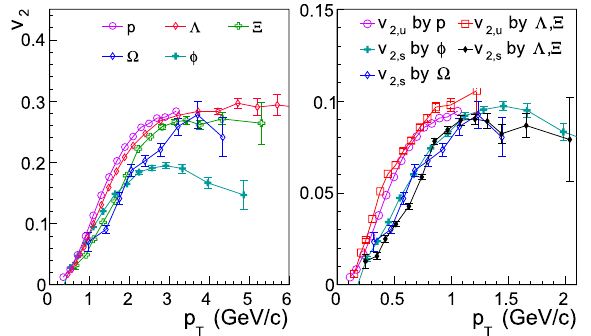
Fig. 1 a Data for v 2 of identified hadrons at midrapidity in Au+Au √ s NN = 200 GeV for 30–80% centrality [6]; b v 2 , u ( p T ) collisions at and v 2 , s ( p T ) extracted from these